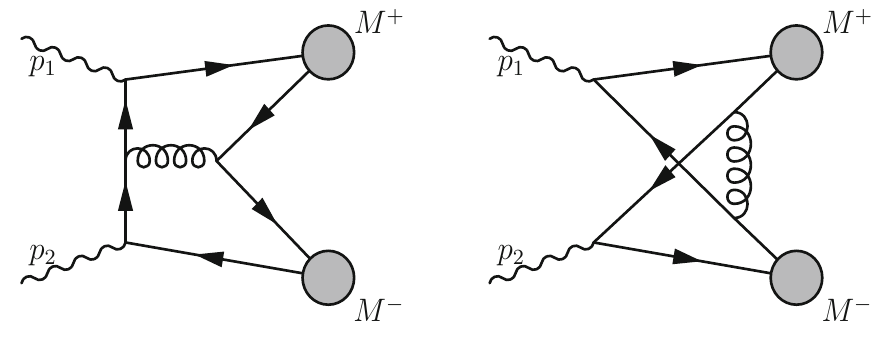
Fig. 1 Feynman diagrams for hard QCD contributions to γγ → M + M